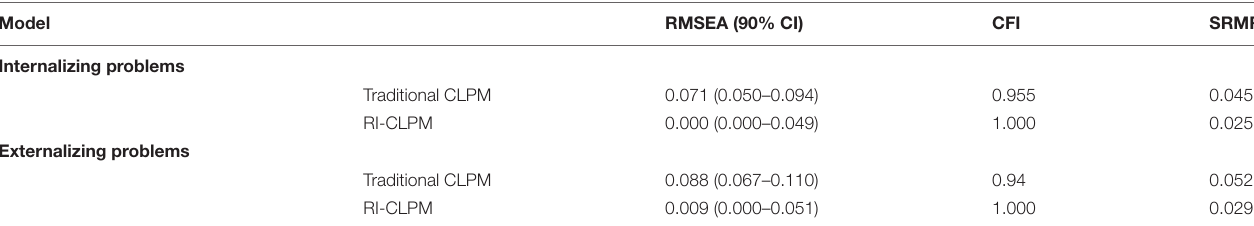
TABLE 3 | Fit indices for traditional and random intercept cross-lagged path models.